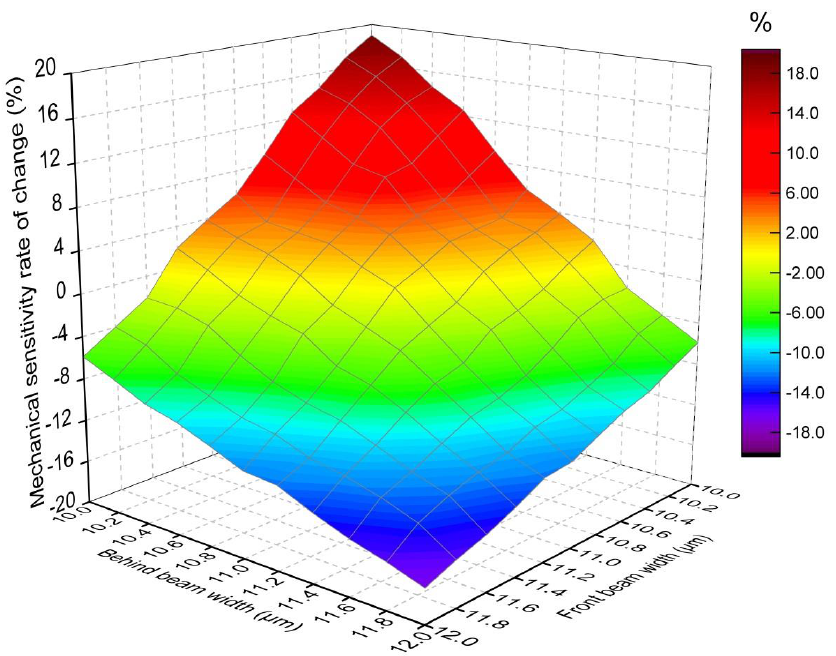
Figure 9. FEM simulation of the tolerance in fabrication by making the double-beam having different